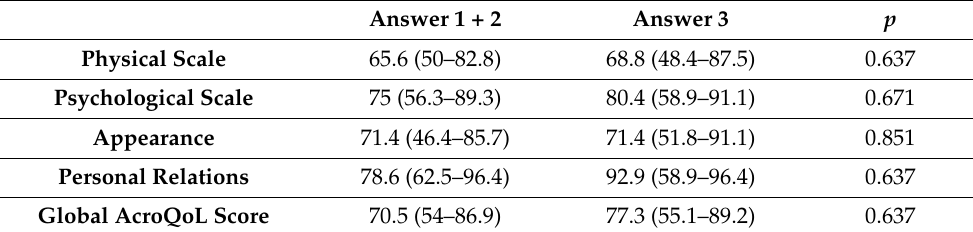
Table 5. The difference in AcroQoL results between different groups divided by general attitude towards the required mask wearing during the